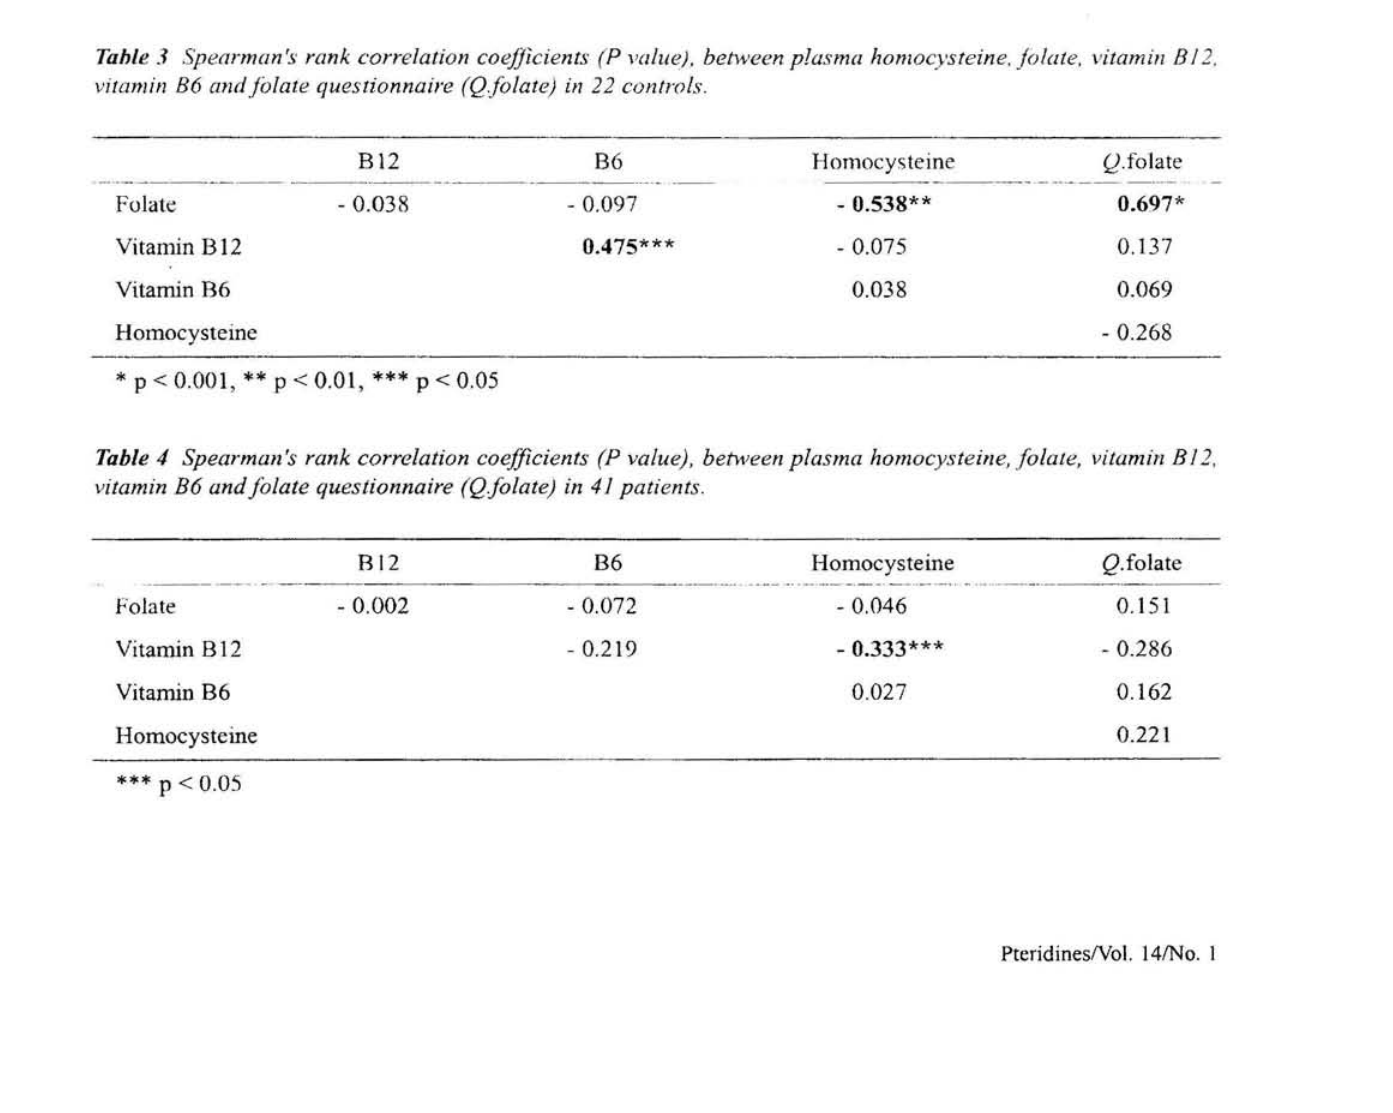
Table .? Spearman's rank correlation coefficients (P value), between plasma homocysteine, folate, vitamin B12. Vitamin B6 and folate questionnaire (Q folate) in 22 controls.